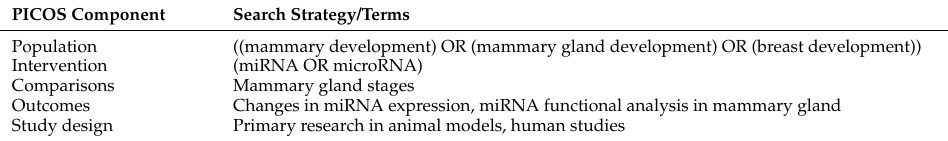
Table 2. Mammary gland development PICOS search strategy as applied in this review.